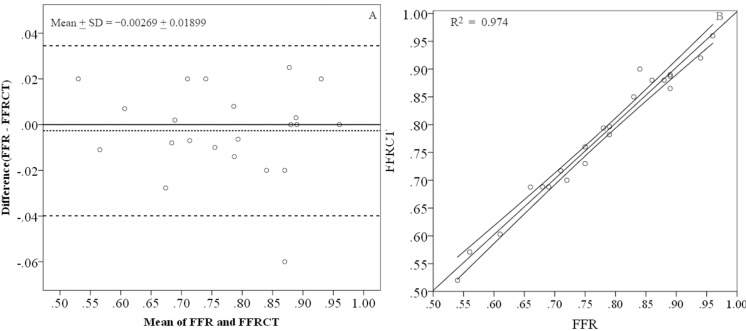
Validation of the calculation is provided by comparing calculated FFRCT to the measurement FFR.A: Agreement between the FFRCTA and FFR is evaluated by Bland-Altman agreement test, the mean±SD bias of is 0.00269 ± 0.01899. B: Agreement between FFRCT and FFR is also evaluated by linear regression that R2 = 0.974 with 95% confident interval.